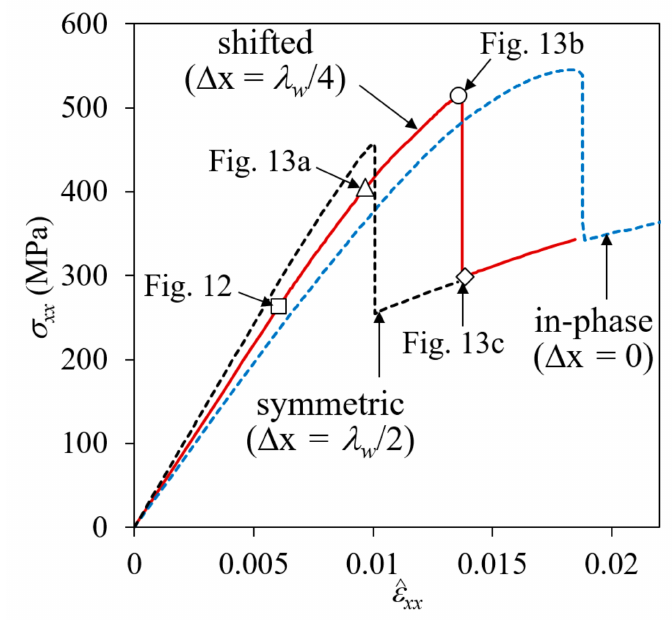
Figure 14. Nominal stress-strain curve for two-ply shifted unit